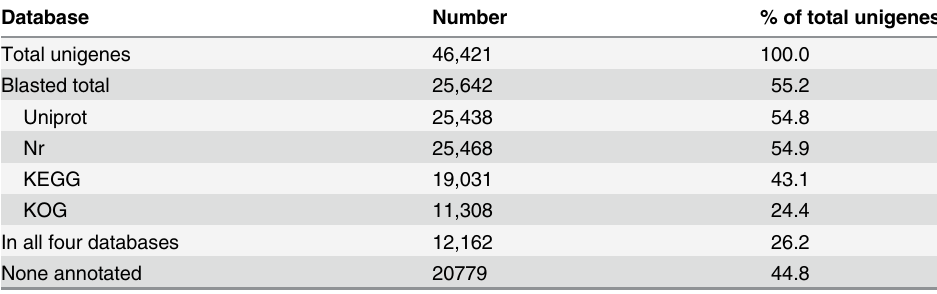
Table 2. Number of annotated unigenes (E < 10 − 5